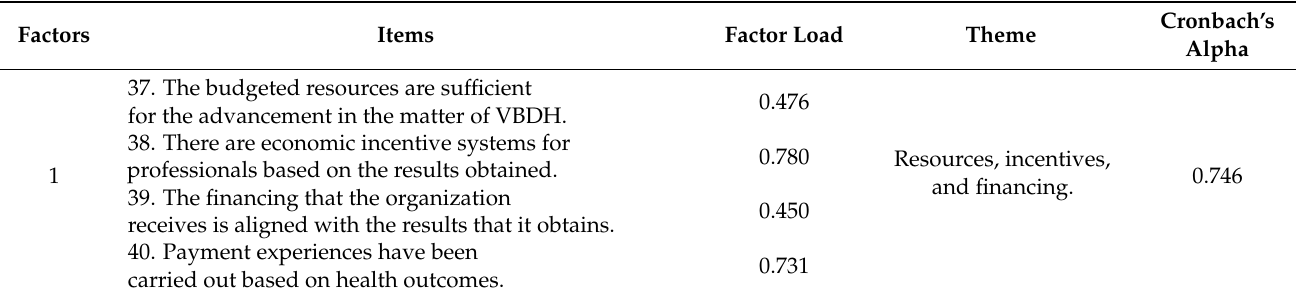
Table 3. Factor analysis